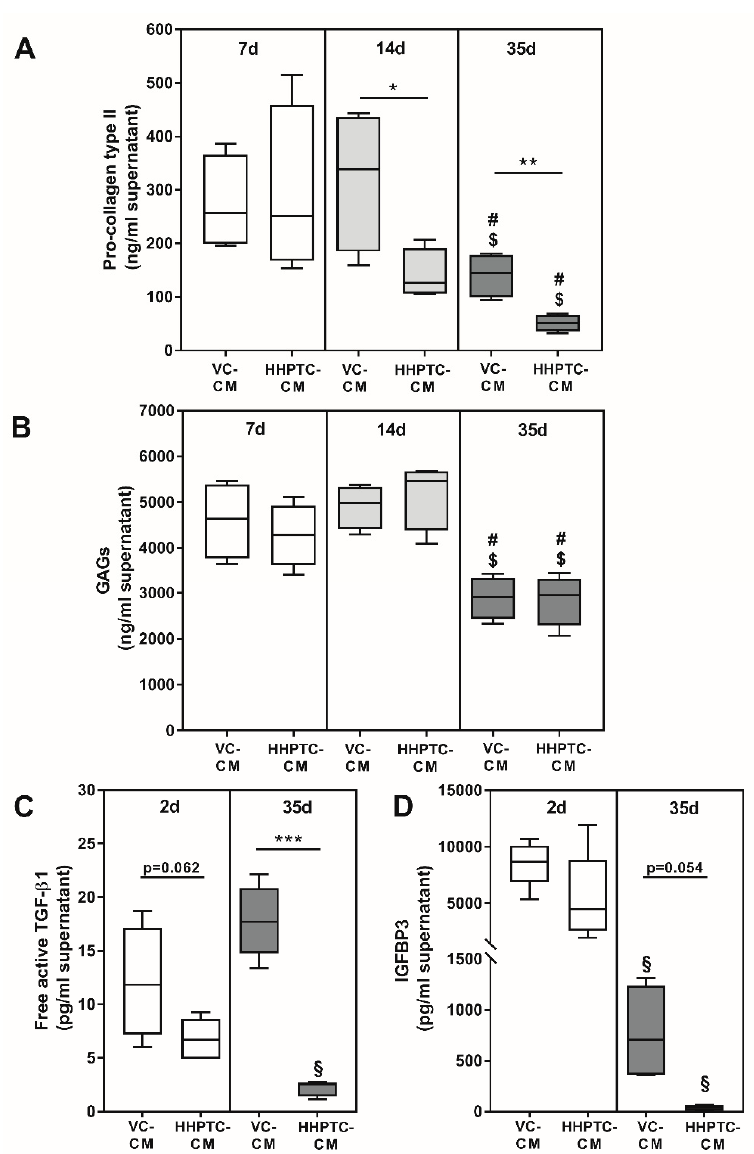
Figure 4. Content of proteins released into conditioned media. Conditioned media (CM) from vital (VC) and high hydrostatic pressure treated cartilage (HHPTC) were analyzed in supernatants generated during days 0 to 2 (2 d), 4 to 7 (7 d), 11 to 14 (14 d) and 32 to 35 (35 d) of cultivation as indicated in the separate graphs. Concentrations of procollagen type II ( A ), free active transforming growth factor (TGF-) β 1 ( C ) and insulin-like growth factor-1 binding protein (IGFBP)3 ( D ) were quantified by enzyme-linked immunosorbent assays (ELISA; all n ≥ 3). Glycosaminoglycans (GAGs) ( B ) were quantified by Blyscan ™ assay after enzymatic digestion with papain ( n = 4). All concentrations are depicted as weight per volume. Data are presented as boxplots with minimum, 25th percentile, median, 75th percentile and maximum. As data were normally distributed according to Shapiro–Wilk test statistical analysis was performed with unpaired t test or unpaired t test with Welch’s correction depending on variances being significantly di ff erent. * p < 0.05, ** p < 0.01 and *** p < 0.001: significance between vital and high hydrostatic pressure treated cartilage. § p < 0.05: significant di ff erence between 2 and 35 days, $ p < 0.05: significant di ff erence between 7 and 35 days and # p < 0.05: significant di ff erence between 14 and 35 days for the same treatment.